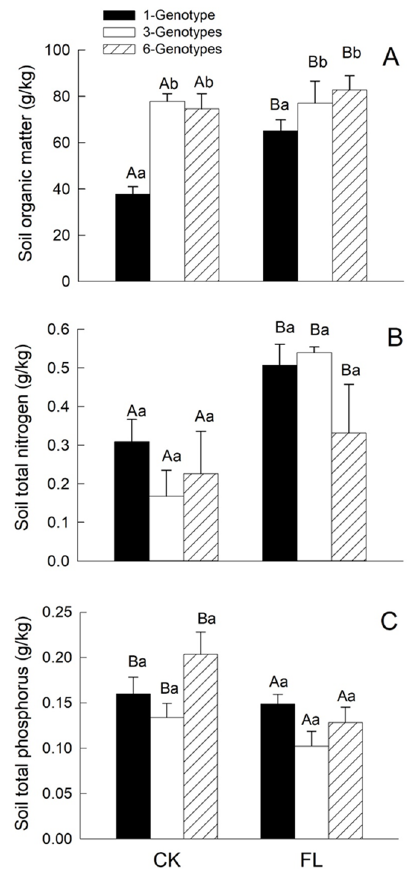
Figure 5. Effects of genotypic diversity and flooding on soil nutrients ( A ) Soil organic matter, ( B ) Soil total nitrogen and ( C ) Soil total phosphorus of the wetland microecosystem (mean ± SE). The control and flooding treatments were named as CK and FL, respectively. Different capital letters indicate significant differences among genotypic diversity treatments, and lower-case letters indicate significant differences among flooding treatments ( p < 0.05).